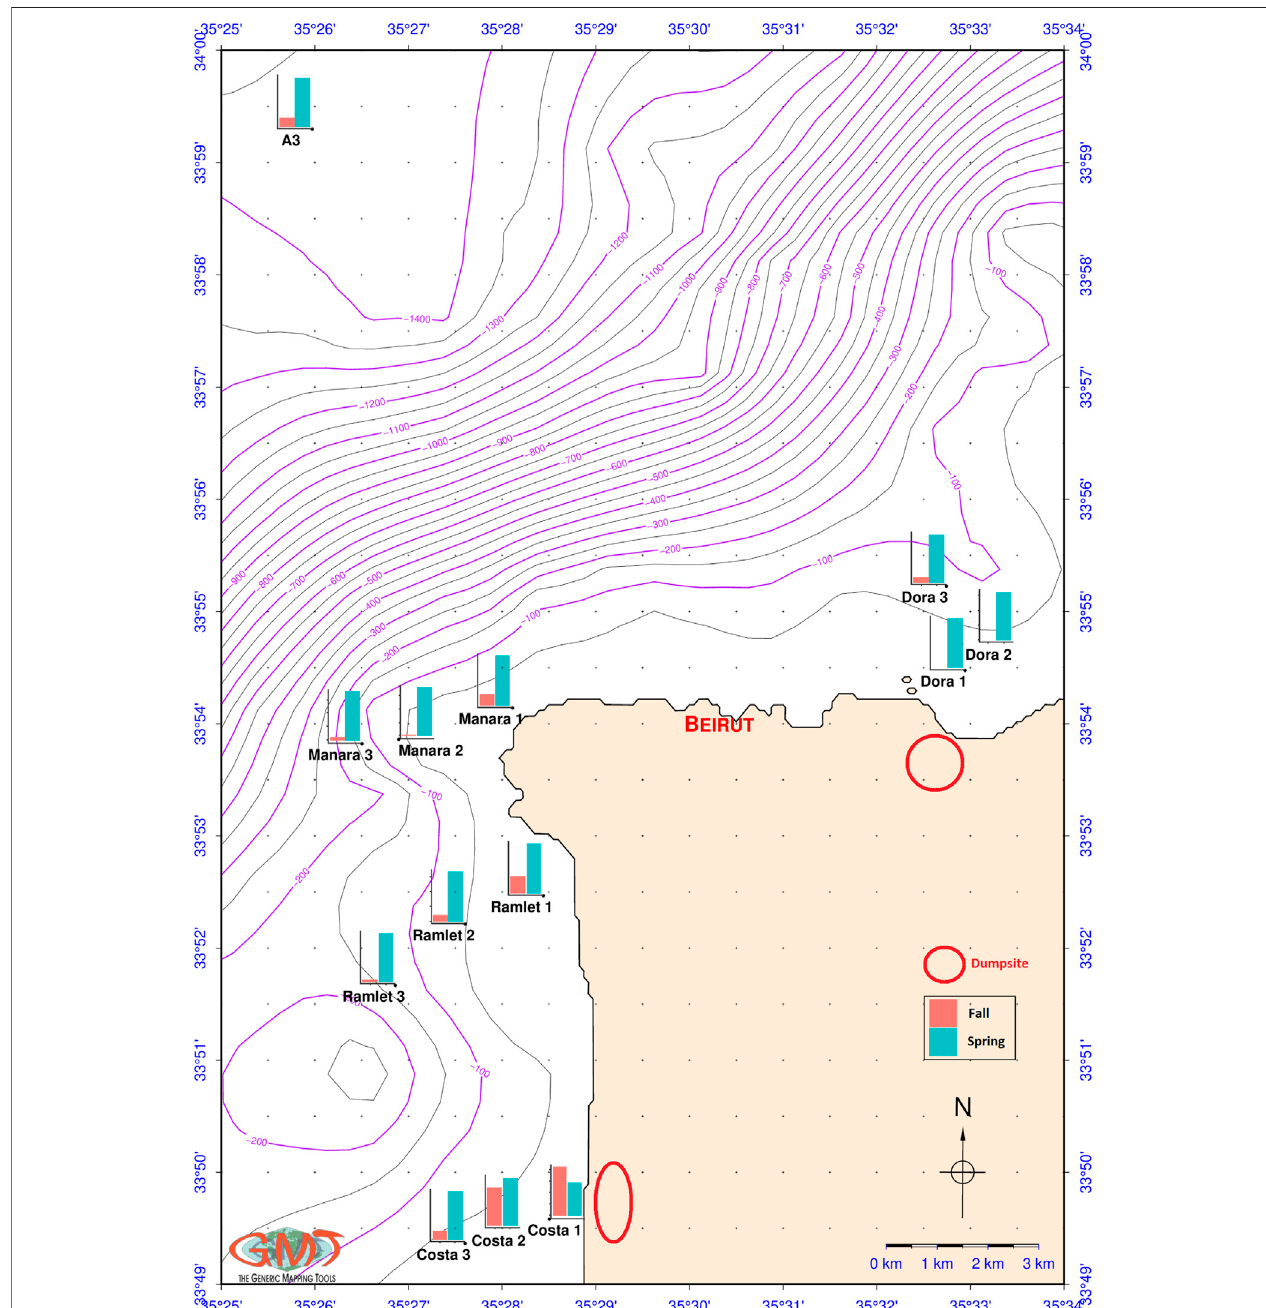
FIGURE 4 | The distribution and concentration (items/m 3 ) of total microplastics during the spring and fall seasons in Beirut marine area.